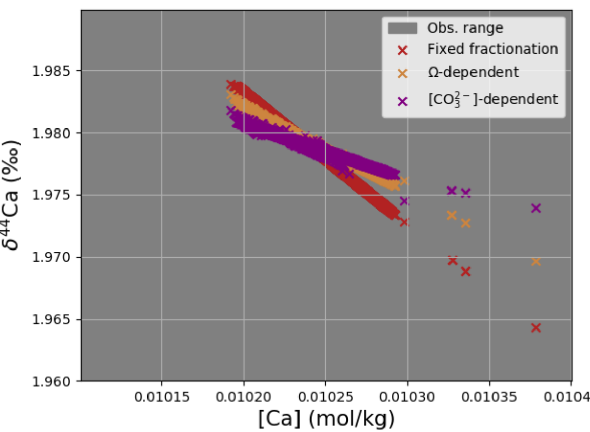
Figure C1. Cross plot of measured and simulated Ca concentrations and isotopic compositions in seawater using different Ca isotope fractionation